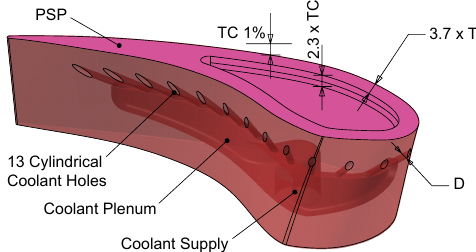
Figure 2. Squealer tip with coolant